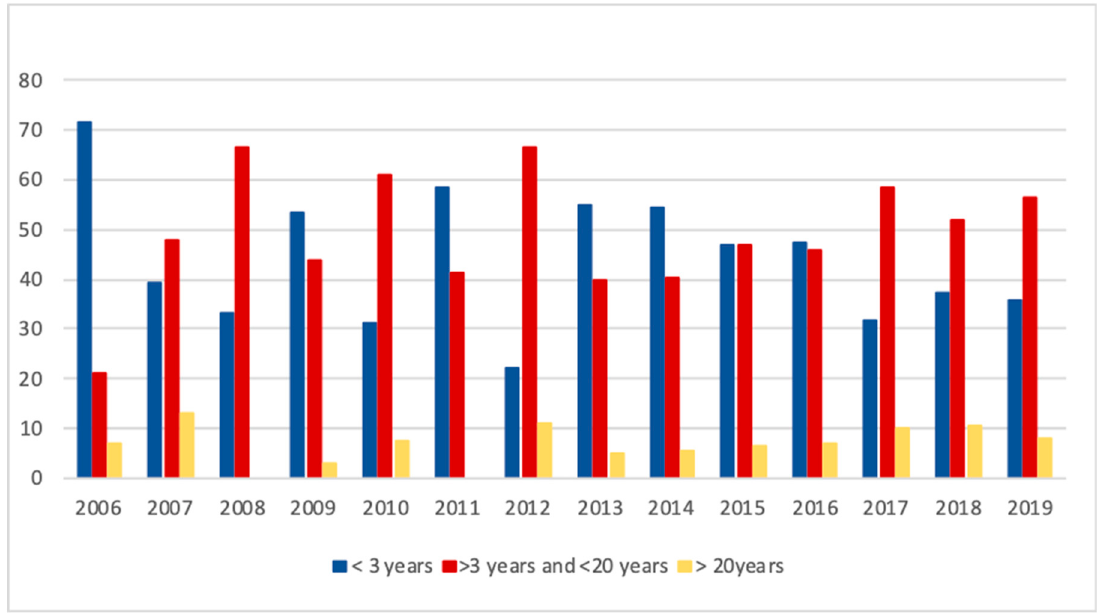
Figure 2. Frequency distribution of equids with age categories: <3 years, >3 years and <20 years and >20 years old (n = 1510) over the study period (2006–2019).